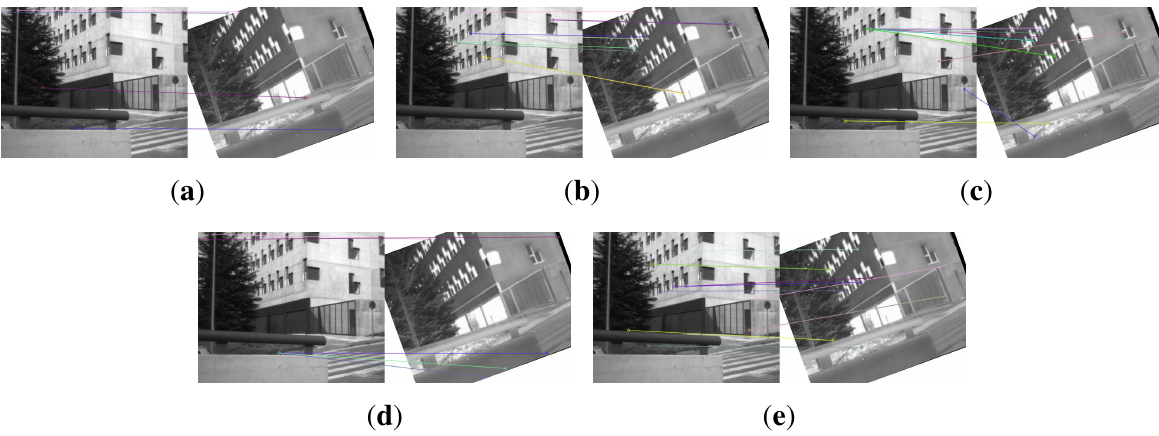
Figure 5. The matched keypoints built with descriptors. ( a ) The original EOH without main orientation; ( b ) the main orientation computed by SIFT, ranging from [0 , 2 π ] ; ( c ) the main orientation computed by COM; ( d ) the main orientation computed by HOI; ( e ) the proposed method that utilizes the main orientation computed by PIIFD. The test (IR) image is rotated by 20 ◦